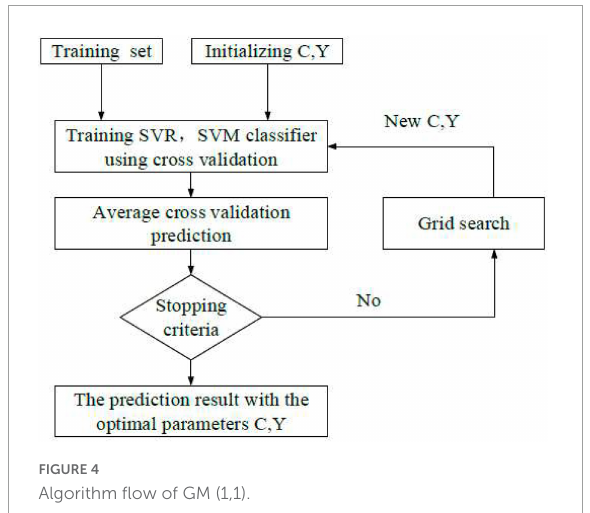
FIGURE4 Algorithm flow of GM